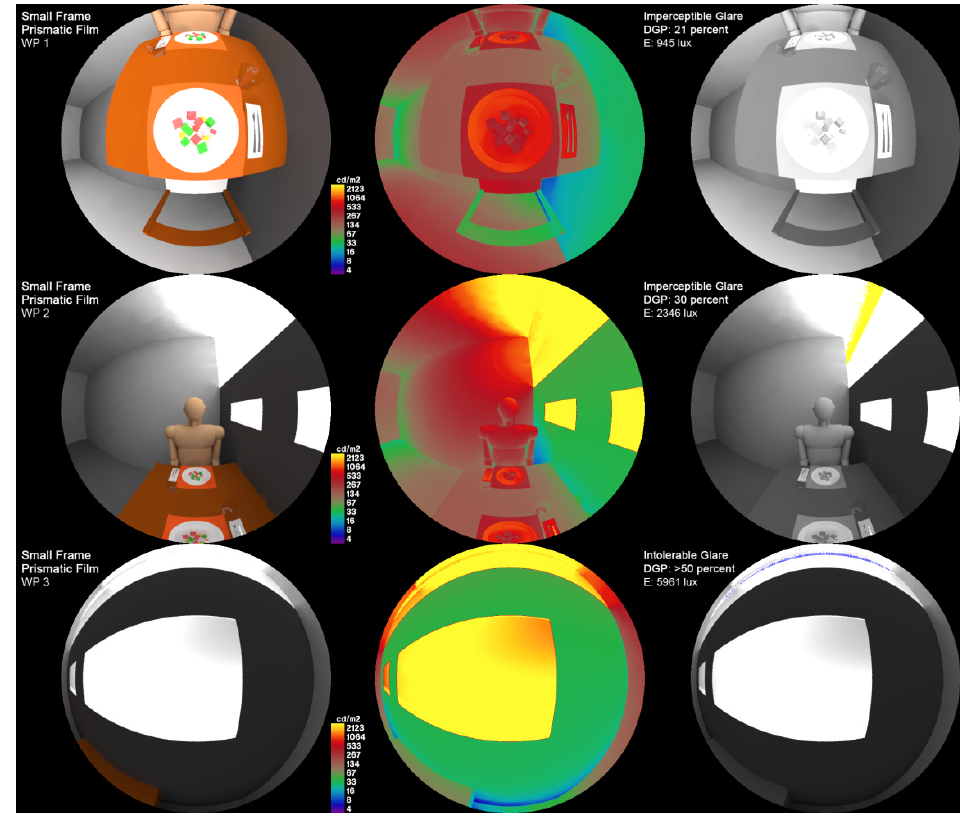
Figure 12 . Visualization, false color image and glare source image with DGP value of window combined by prismatic film CFS façade system from the same point of view and the work plane, relation plane and out plane that contribute in this complete visual field.